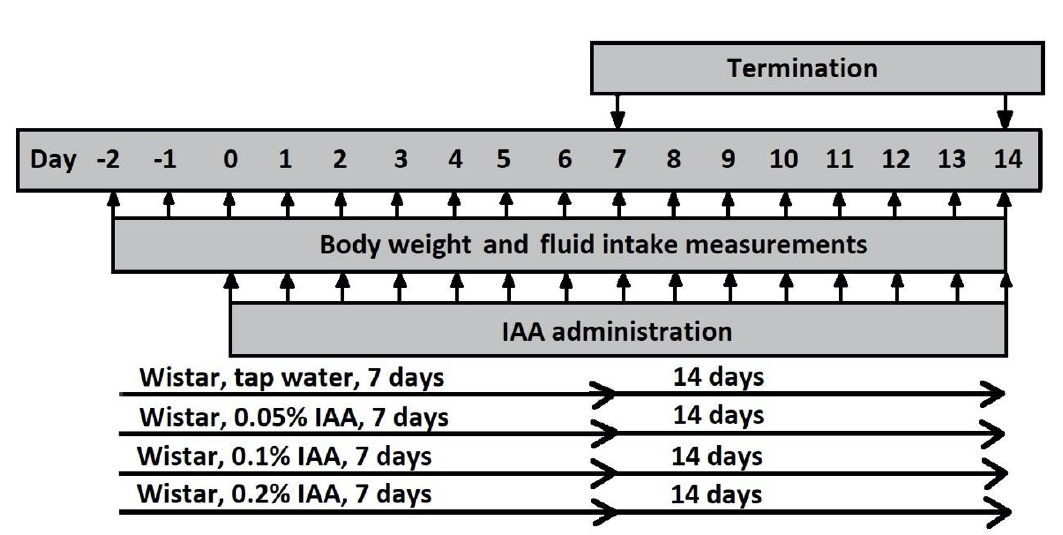
Figure 9. Experimental design of IAA gastritis with Wistar rats. Male Wistar rats were divided into 8 groups according to the duration of the protocol (7 days or 14 days) and concentration (0.05%, 0.1% or 0.2%) of IAA dissolved in drinking water. Control rats received tap water. Body weight and fluid intake were monitored daily throughout the experiment. At the end of the protocol, rats were euthanized and their stomachs were excised for macroscopic, microscopic evaluation and further molecular biological assessment.